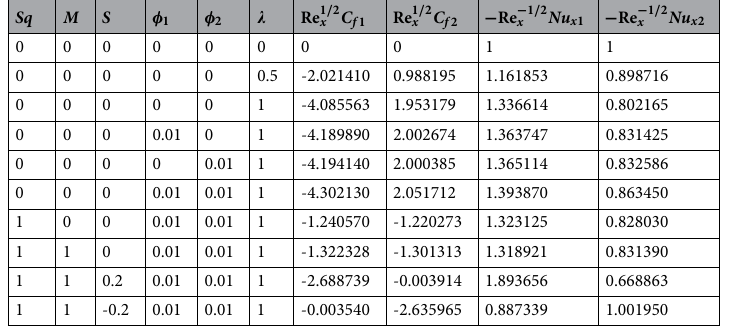
Re − 1 / 2 x Nu x 2 with various values of the